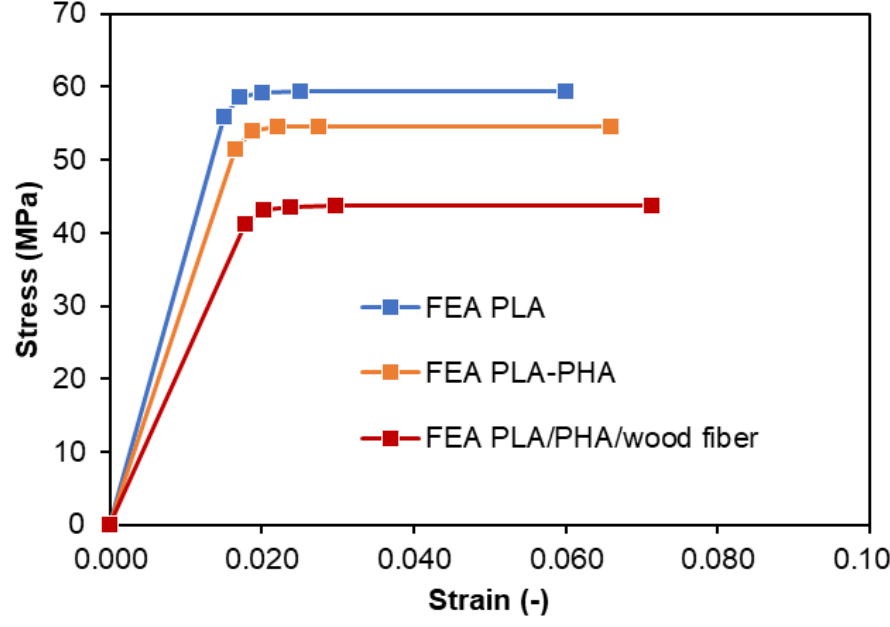
Figure 12. FEA-generated stress – strain curves of the PLA composites.